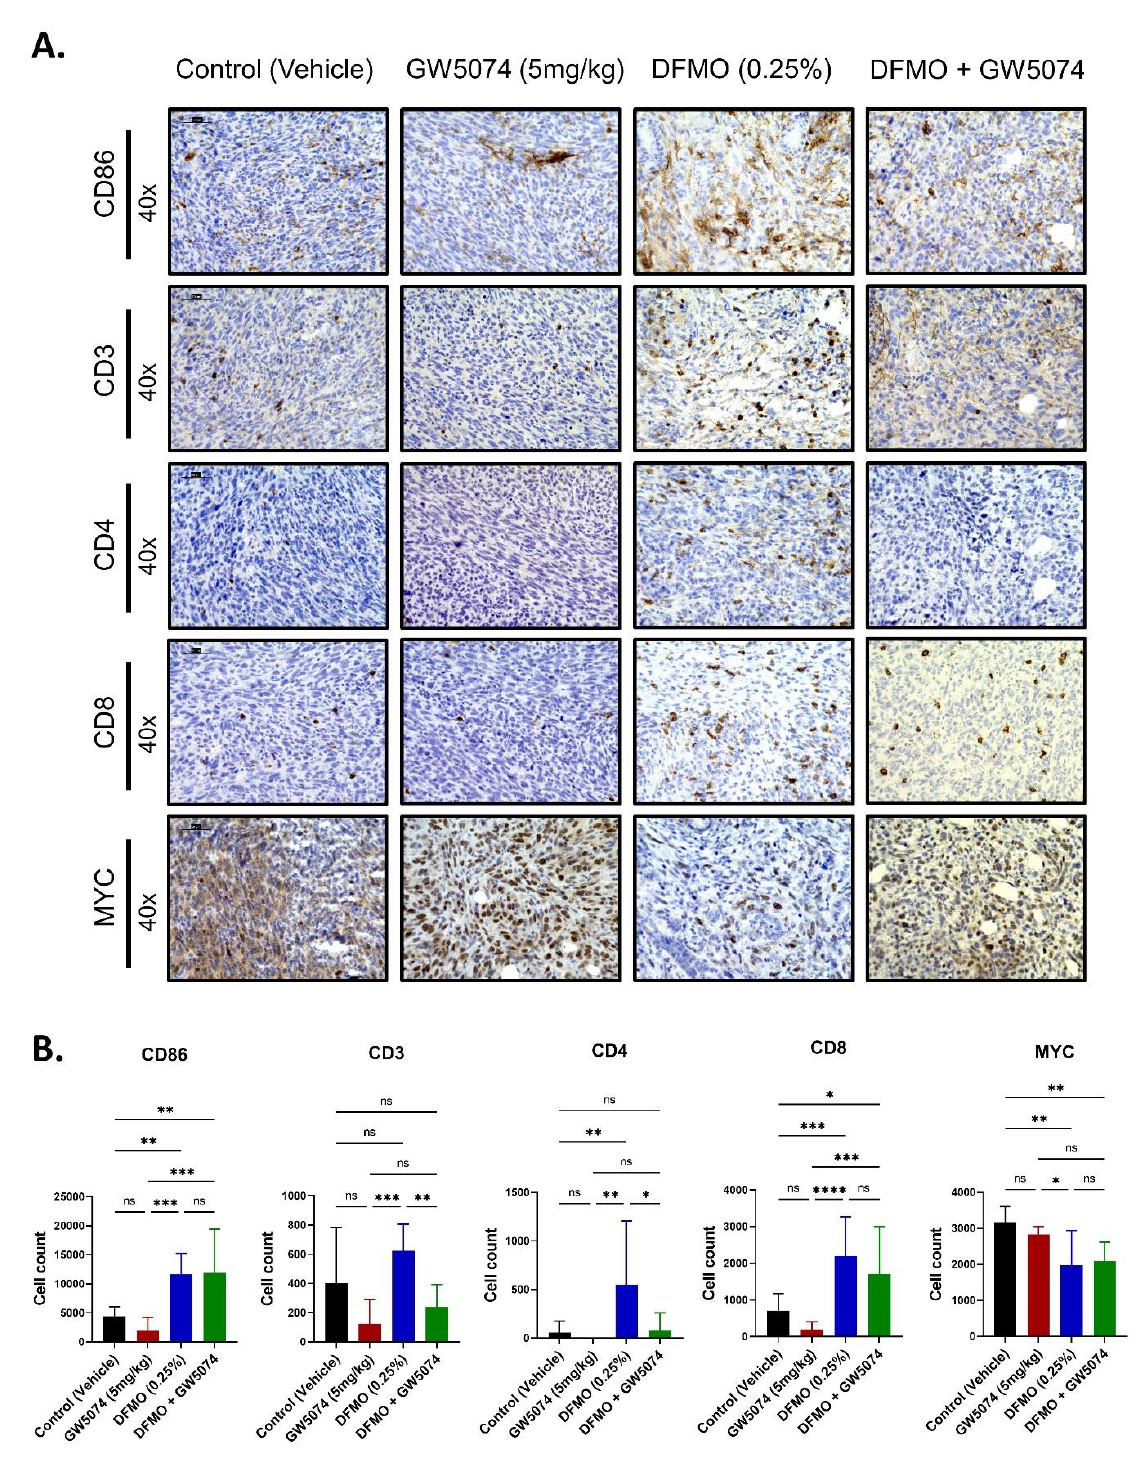
Figure 4. Increased T-cell infiltration in DFMO-treated pancreatic tumors. Tumor sections from PAN 02-injected mice treated after one week with control, GW5074 (5 mg/kg), DFMO (0.25% w / v ) and DFMO + GW5074 for a total of four weeks. ( A ) Representative immunohistochemistry images of CD86, CD3, CD4, CD8 and MYC-stained pancreatic tumor sections imaged at 40 x magnification. Scale bars correspond to 50 μm. ( B ) Quantification of CD86, CD3, CD4, CD8 and MYC-positive cells across treatment groups. A one-way ANOVA followed by post hoc Tukey’s test for multiple comparison was used to analyze statistical significance between treatment groups. ( p < 0.05 [*], p < 0.01 [**], p < 0.001 [***], p < 0.001 [****]).